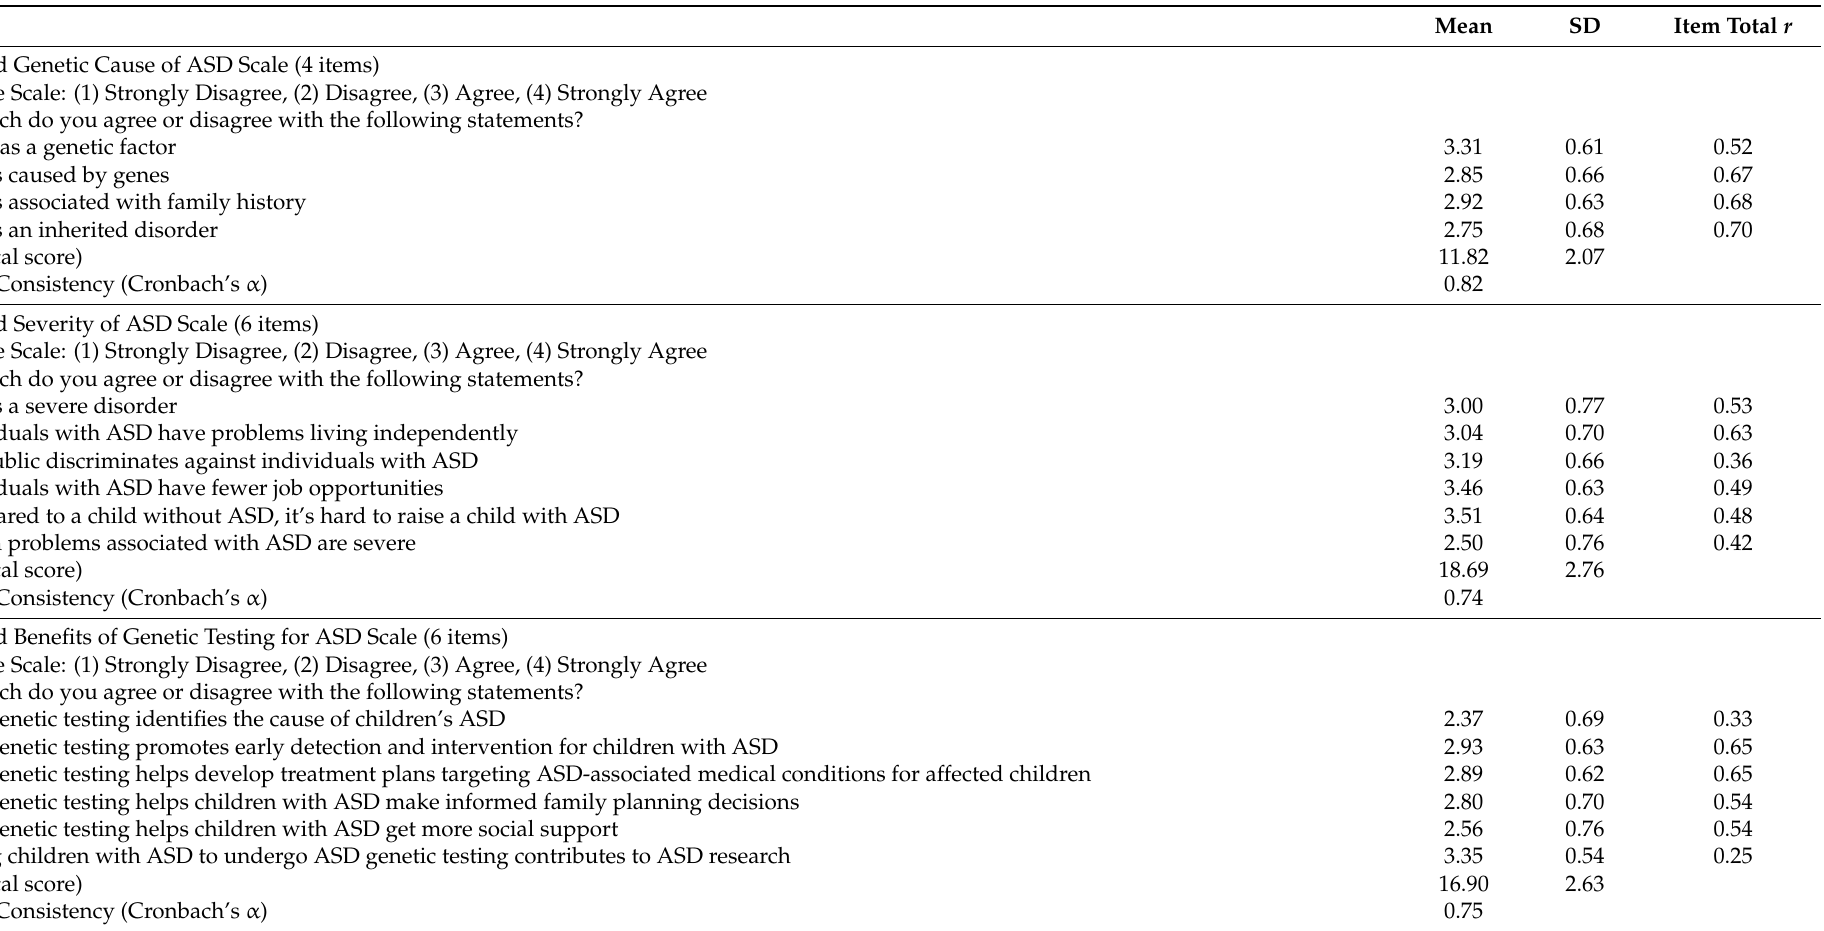
Table 1. Means, standard deviations, item-total correlations, and Cronbach’s alpha ( α ) coefficients for scales within the